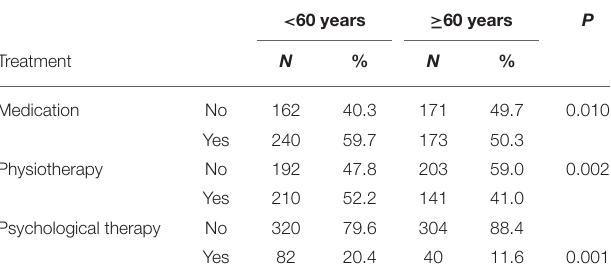
TABLE 7 | Therapy for vertigo/dizziness in both age